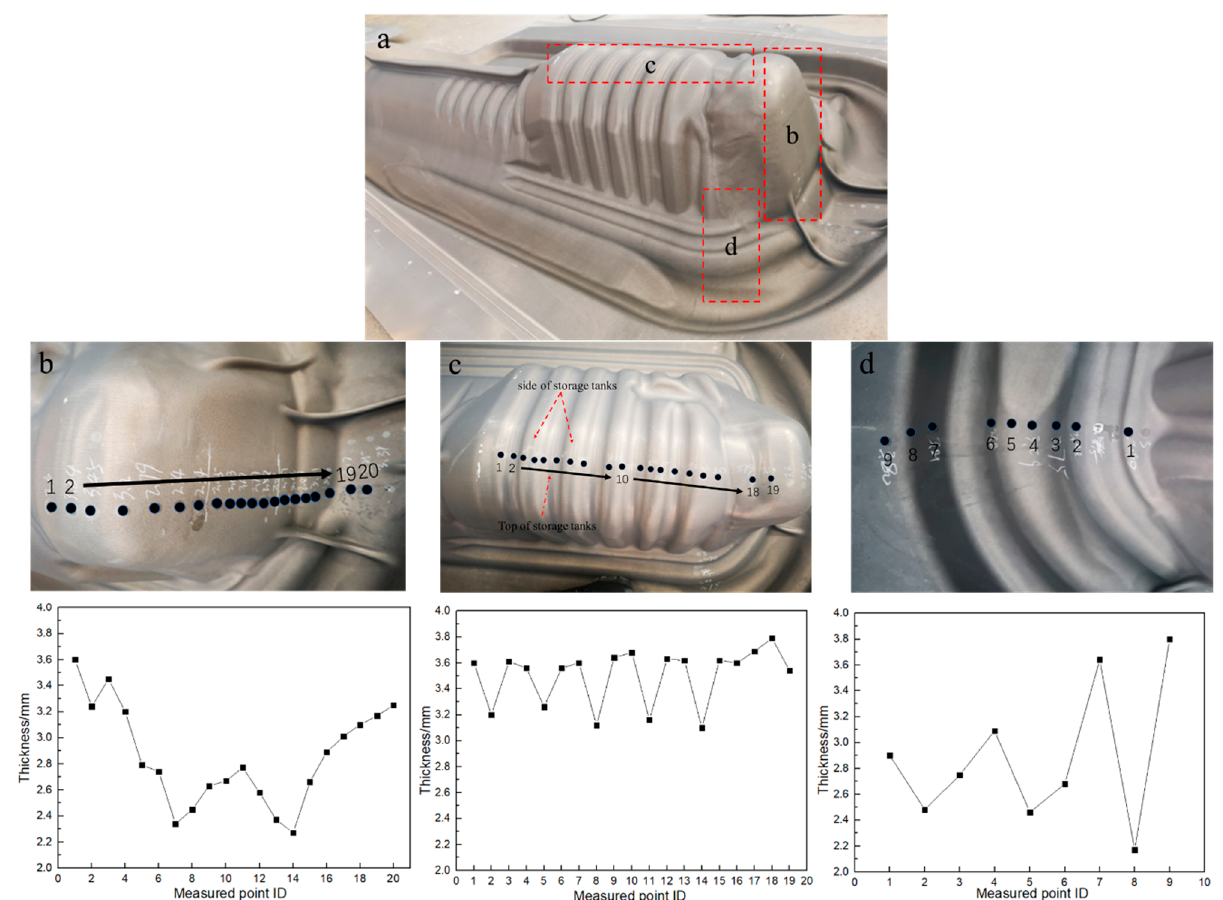
Figure 14. Measurement point ID and thickness: ( a ) preforming structure; ( b ) end; ( c ) longitudinal storage tanks; ( d ) trans- verse storage tanks.